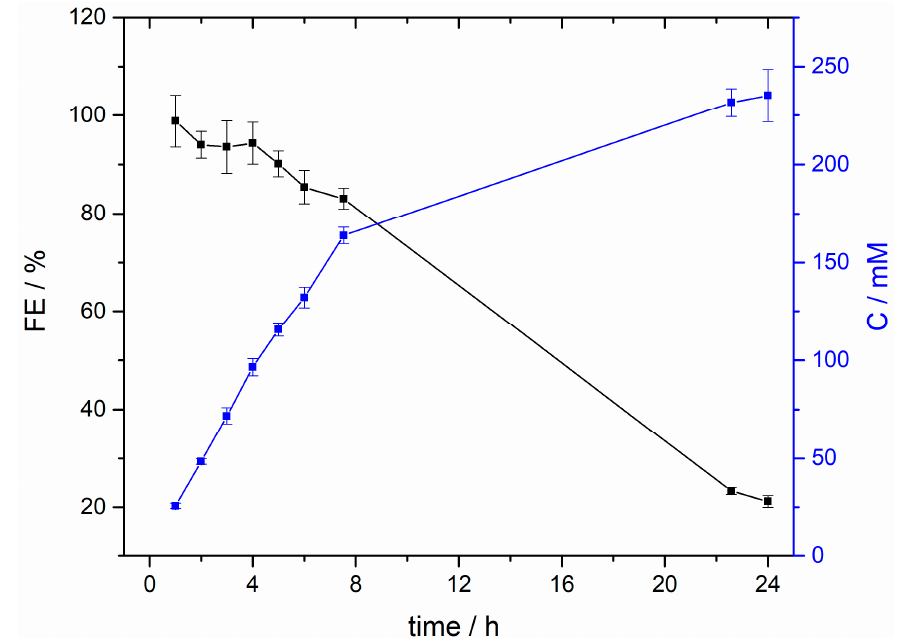
Figure 6. Faradaic efficiency and formate concentration vs time during 24 h CO 2 electroreduction electrolysis at − 1.6 V.